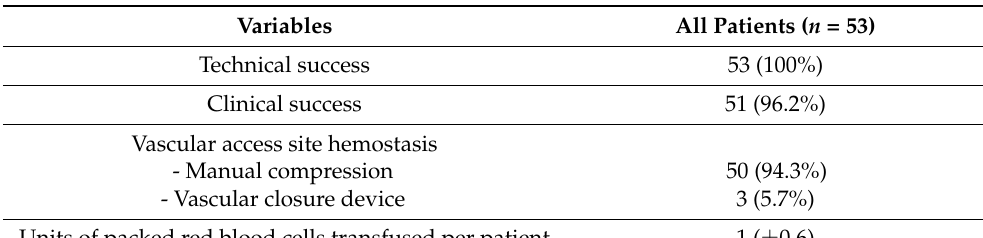
Table 3. Outcome